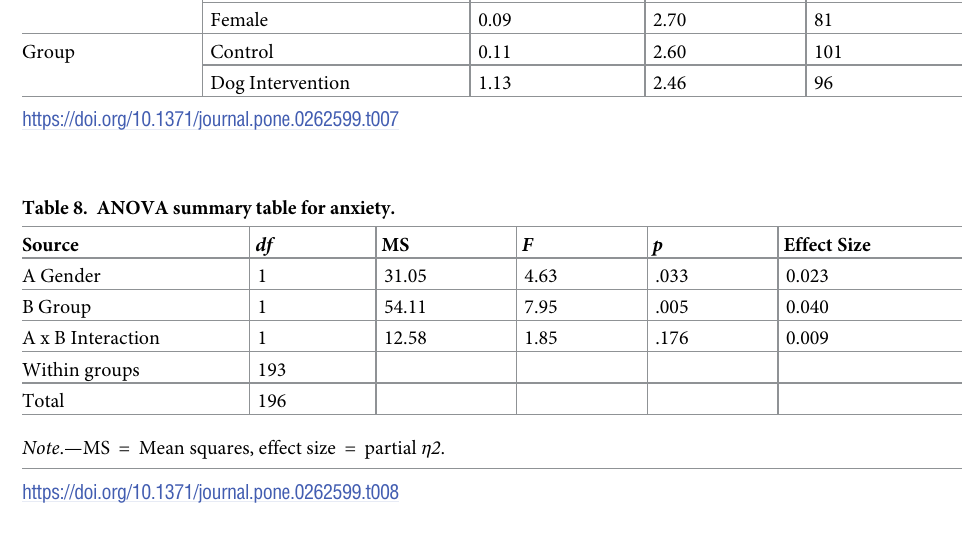
Table 9. Proportion of participants in each pain change response category and chi-square statistics. Anxiety